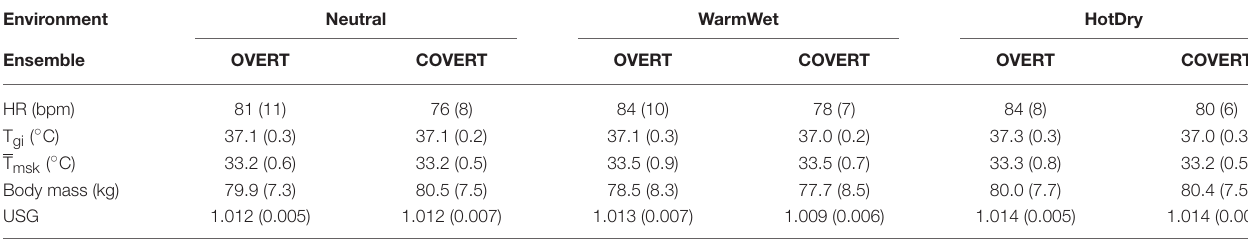
TABLE 2 | Mean (SD) baseline physiological and hydration indices within each environment and ensemble.